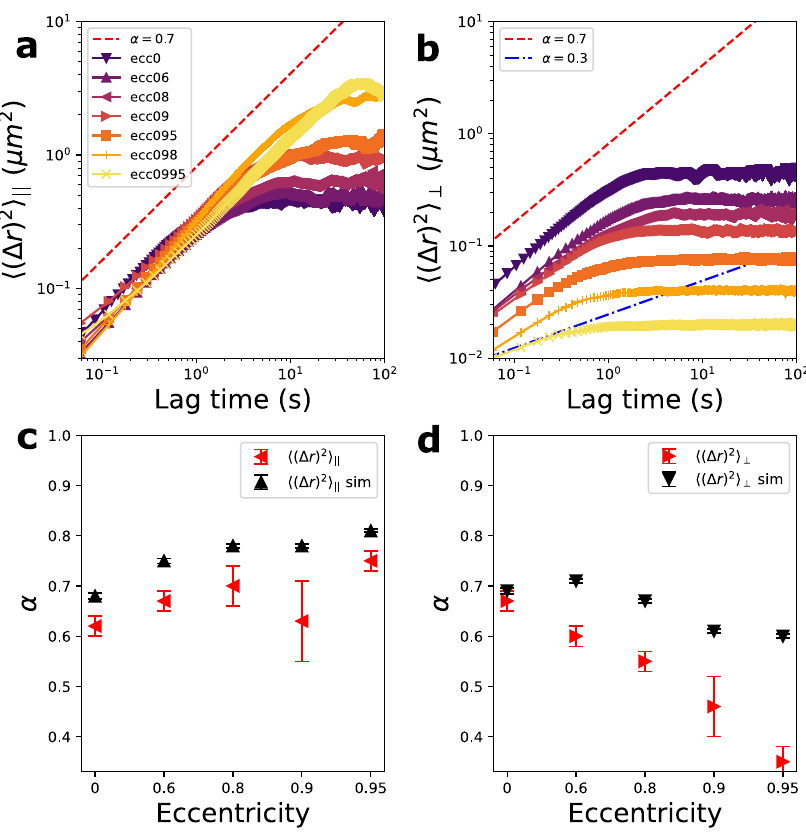
Fig. 7 Mean-squared displacement of a cavity con fi ned plasmid in presence of T 4 -DNA. a The major axis component of the MSD extracted from the plasmid con fi ned in different cavities. b The minor axis component of the MSD extracted from the plasmid con fi ned in different cavities. c The scaling exponent of hð Δ r Þ 2 i jj extracted from experiments (red points) and simulations (black points). d The scaling exponent of hð Δ r Þ 2 i ? extracted from experiments (red points) and simulations (black points). The red error bars give the standard error of the mean of α over captured videos ( n = 5 for e = 0, n = 7 for e = 0.6, n = 8 for e = 0.8, n = 9 for e = 0.9, n = 15 for e = 0.95). The black error bars give the standard error of the mean of α over simulation clips ( n = 250 clips with 3000